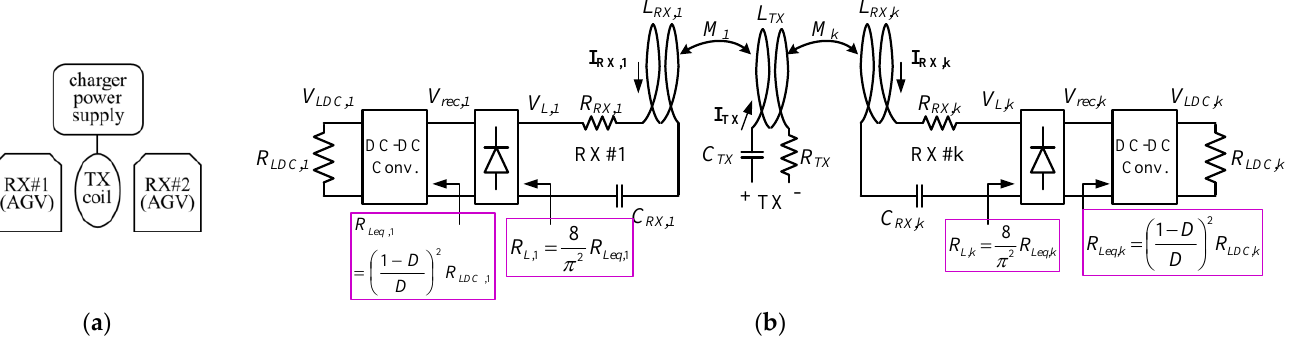
Figure 1. Wireless charging of multiple automatic guided vehicle (AGV), simultaneously. ( a ) Top view. One TX coil is in between two RXs and charges the two RXs simultaneously. ( b ) Equivalent circuit. The R LDC,k is the end-user DC load. The R Leq,k is the effective resistance transformed from R LDC,k . The R L,k = 8/π 2 * R Leq,k is the resistance that the RX coil actually sees [14,15]. The AC/DC rectifier is not related to control.